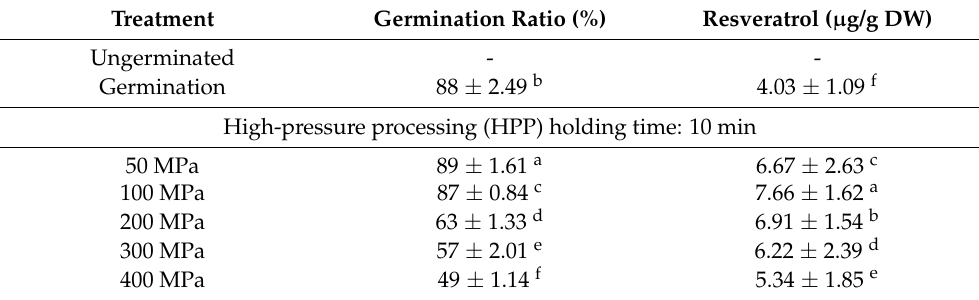
Table 3. Effects of high-pressure processing treatment under different pressures for 10 min on the germination ratio and resveratrol content of germinated peanuts.